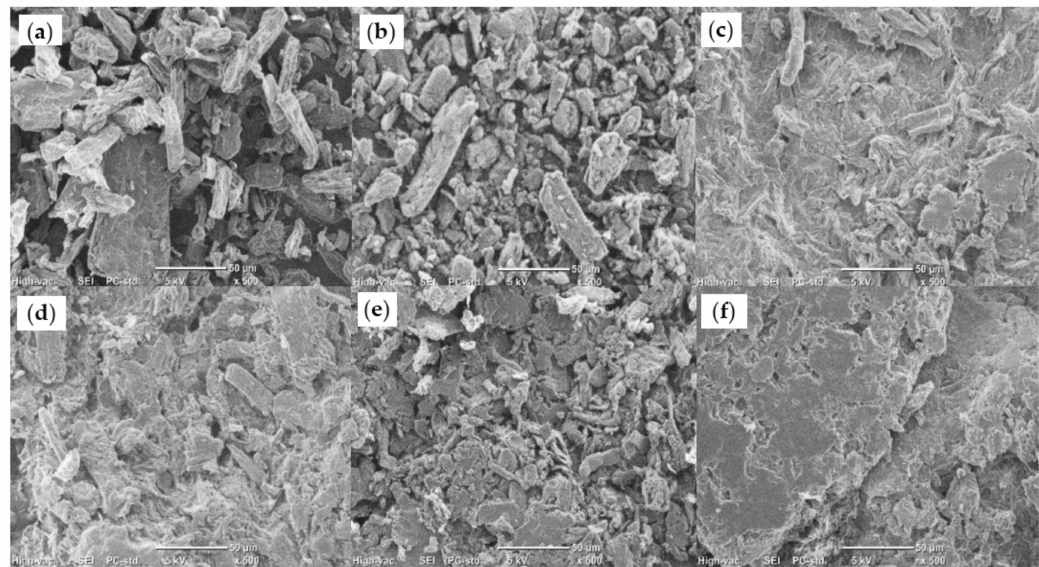
Figure 6. SEM images of ( a ) pristine MCC; ( b ) cellulose oleate 50 ◦ C 12 h; ( c ) cellulose oleate 100 ◦ C 12 h; ( d ) cellulose oleate 80 ◦ C 4 h; ( e ) cellulose oleate 80 ◦ C 12 h; ( f ) cellulose oleate 80 ◦ C 24 h.